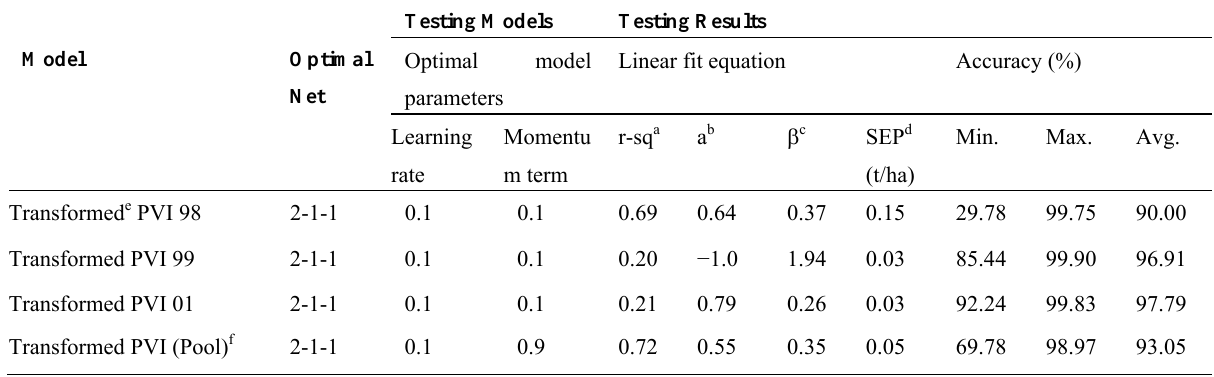
a coefficient of determination, b intercept, c Slope of the linear fit model, and d Standard error of prediction of the model based on log 10 transformed